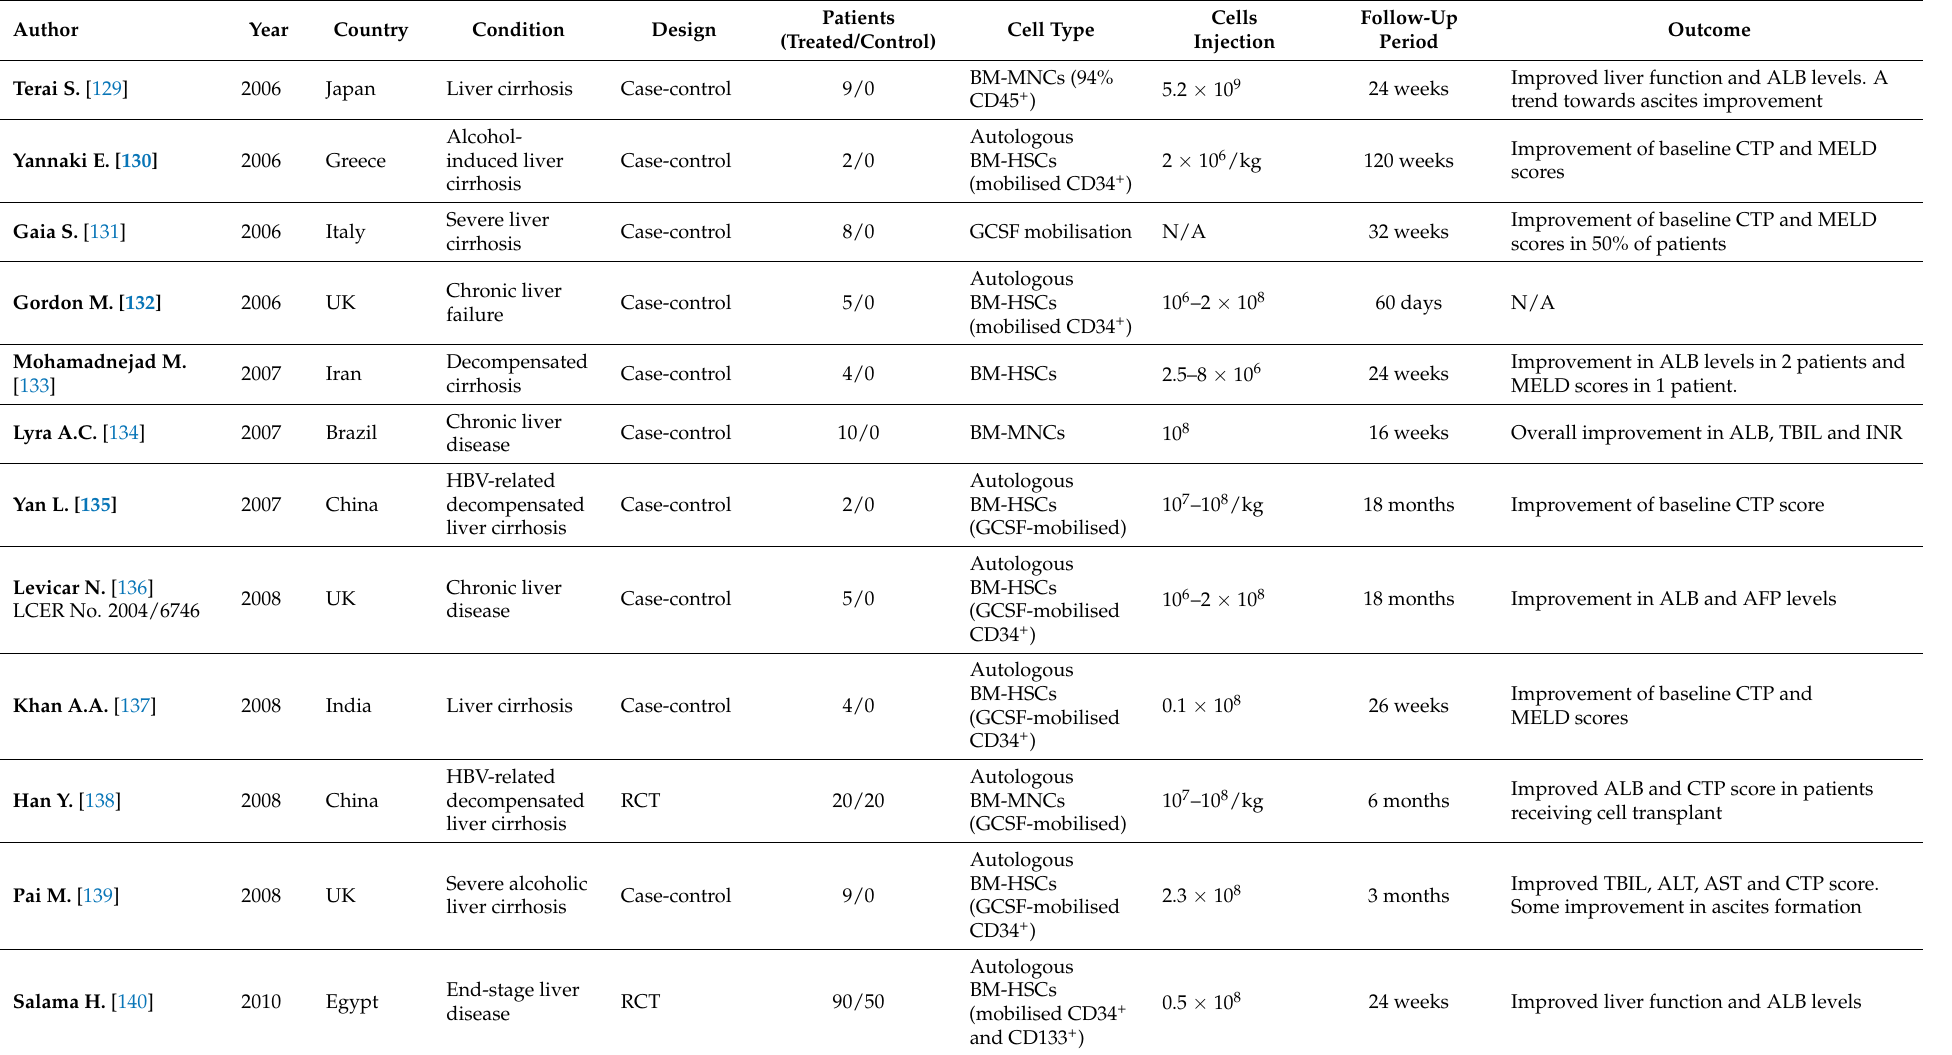
Table 1. Clinical studies using hematopoietic cells for transplantation in patients with liver